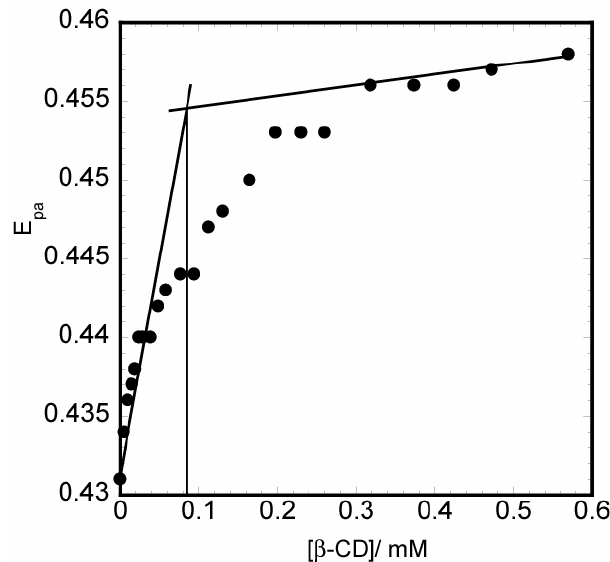
, against the Plot of the potential of the oxidative current peak, E pa concentration of β -CD. Oxidation potential peaks of 1 were determined by CV measurements with a dA dT -immobilized electrode in 0.1 M AcOK- 20 20 AcOH buffer (pH 5.6) containing 0.1 M KCl and 0.05 mM 1 in the presence of a various amount of β -CD at 25 °